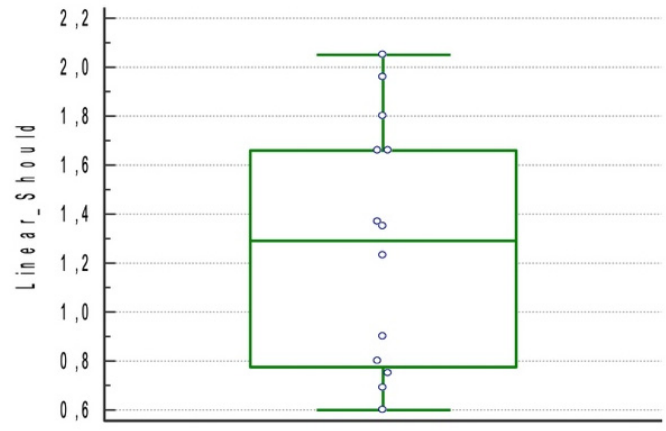
Figure 6. Boxplot for linear deviation at shoulder point of the included studies. The resulted linear deviation at apex point was 1.46 mm ± 0.54 mm (95% CI 1.17–1.74) (Figure 7).